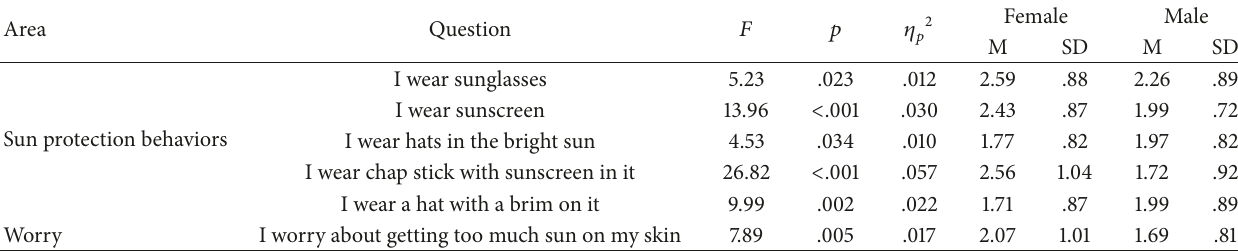
Table 3: Univariate tests for gender and means and standard deviations for females and males.